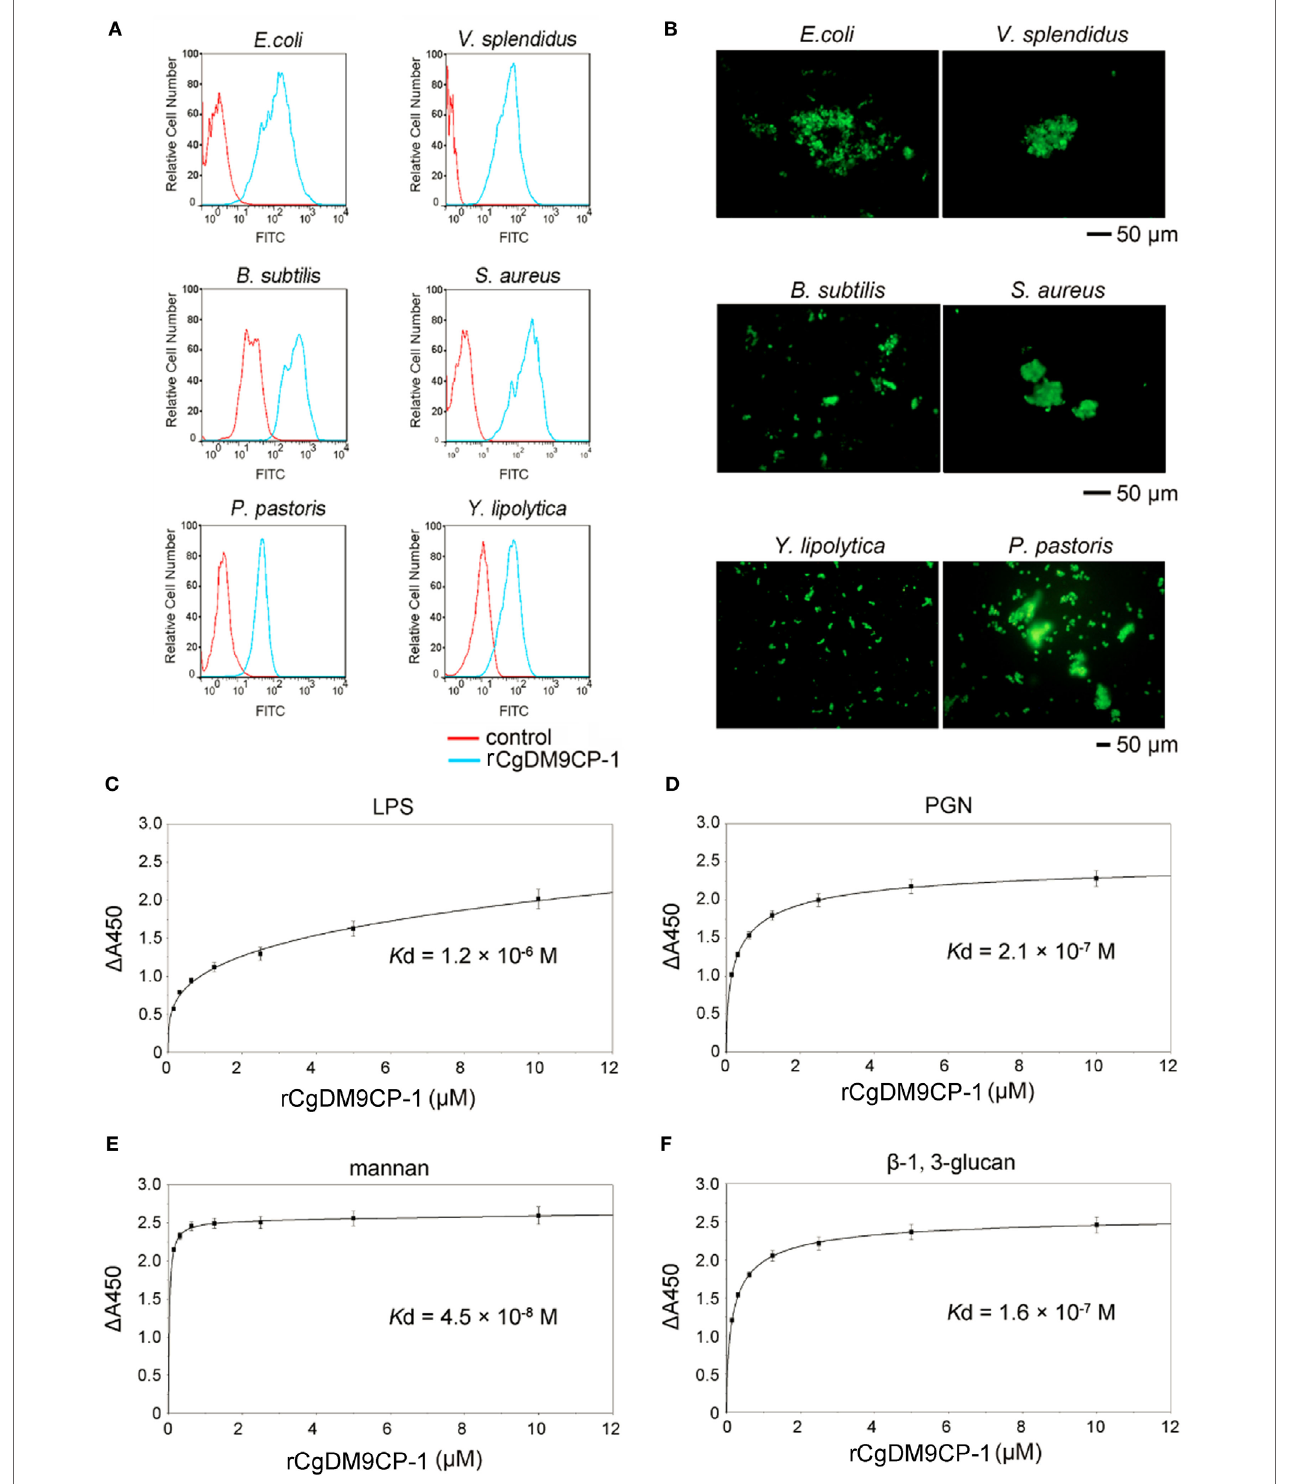
FigUre 3 | Recombinant Crassostrea gigas DM9 domain containing protein 1 (rCgDM9CP-1) exhibited broad microbial and pathogen-associated molecular pattern (PAMP) recognition activity. The microbial binding activity of rCgDM9CP-1 was determined by flow cytometry (a) , and the agglutination activity was analyzed by fluorescent microscopy (B) . The quantitative binding of rCgDM9CP-1 (0–10 µM) to immobilized lipopolysaccharide (LPS) (c) , peptidylglycan (PGN) (D) , mannan (e) , and β -1, 3-glucan (F) was determined by enzyme-linked immunosorbent assay ( n = 6).